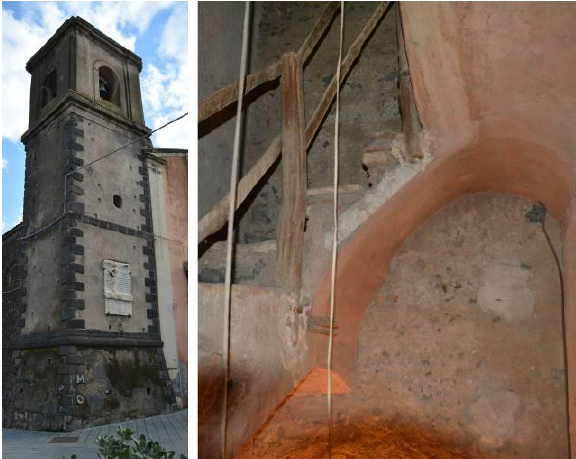
Figure 6. The bell tower of San Giuseppe in Aci Castello (Ct). Stairs on rampant